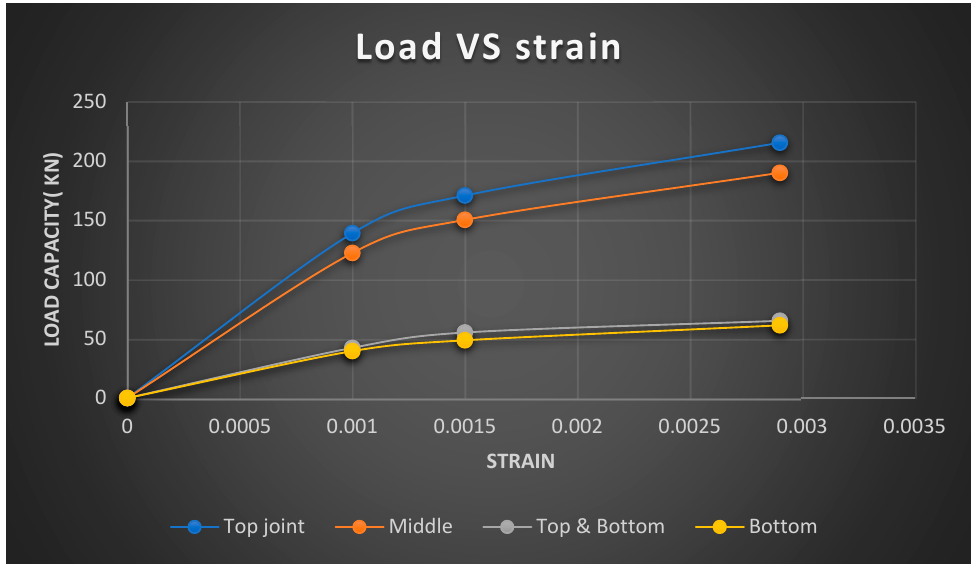
Figure 13. Comparison of capacity load of TDGLC +TG.